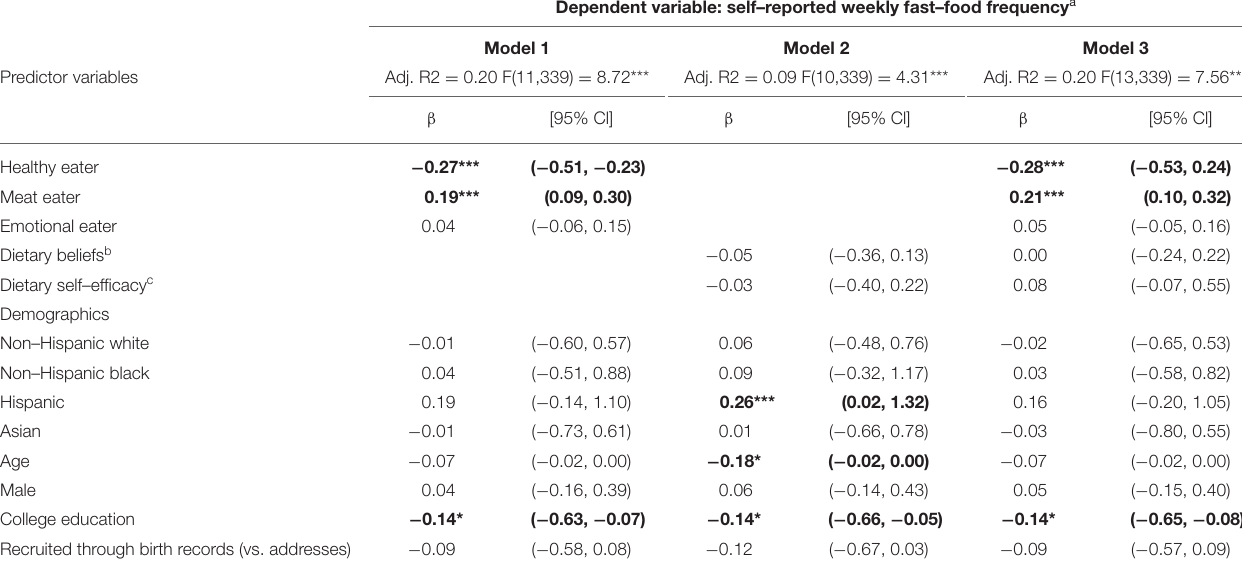
TABLE 4 | Linear regressions predicting self–reported weekly fast–food frequency. Dependent variable: self–reported weekly fast–food frequency